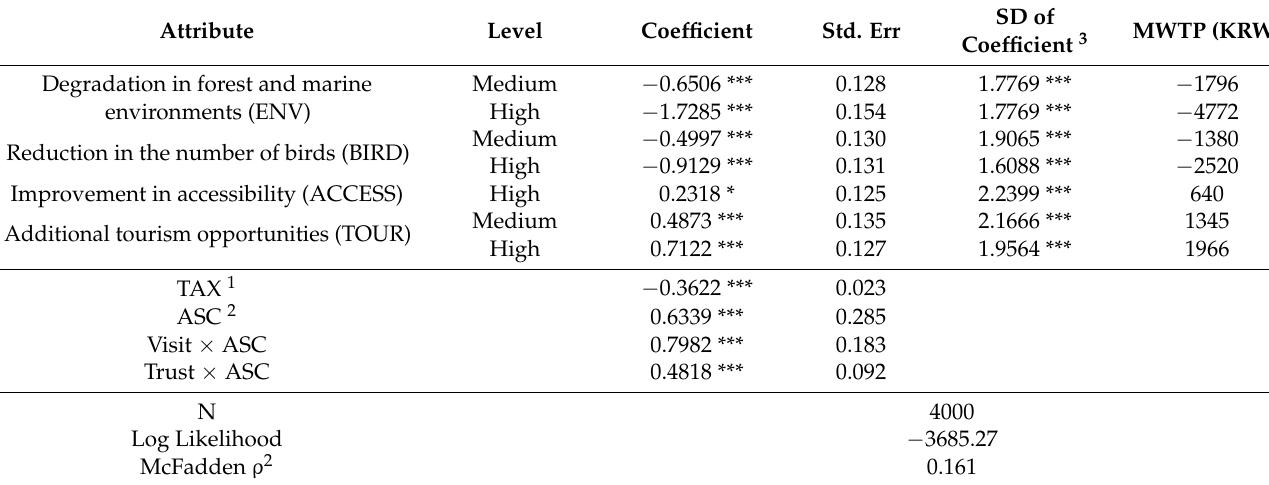
Table 3. Results of the random parameter model (aggregate